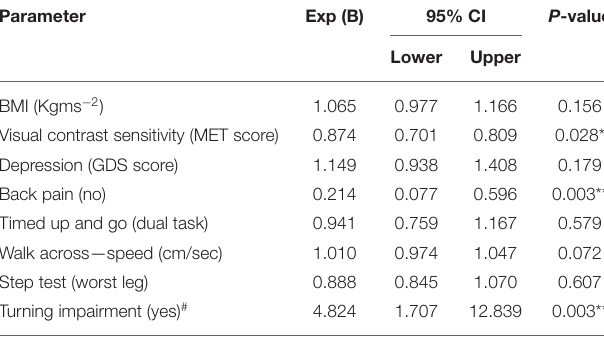
TABLE 6 | Multiple logistic regression association with fall